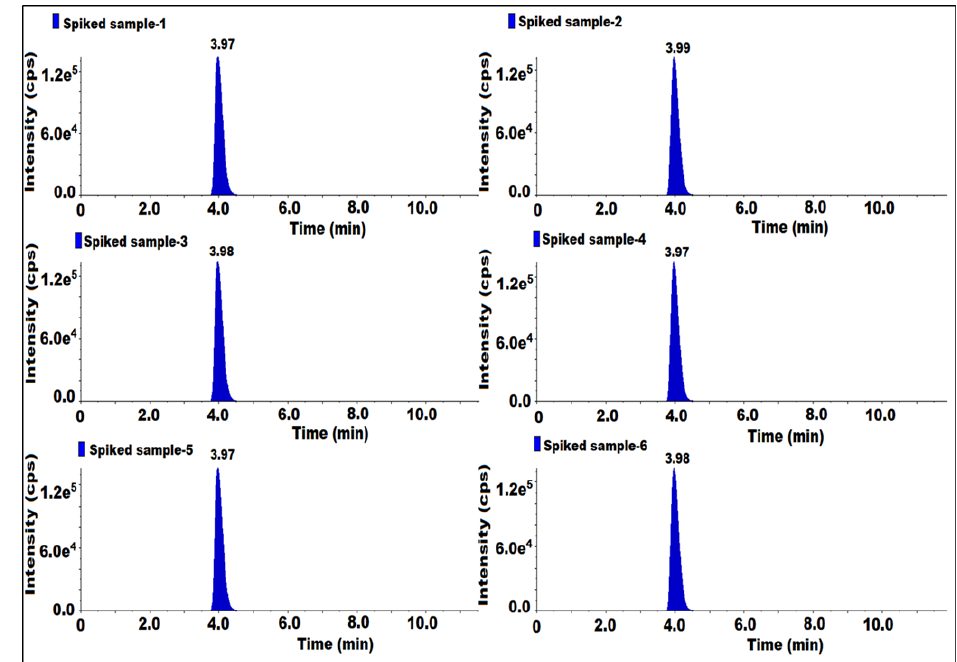
Figure 6. MS/MS MRM chromatogram of method precision. Table 3. Summary of method validation results .